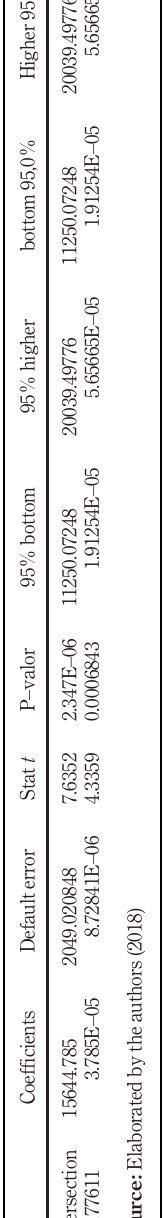
coefficient analysis